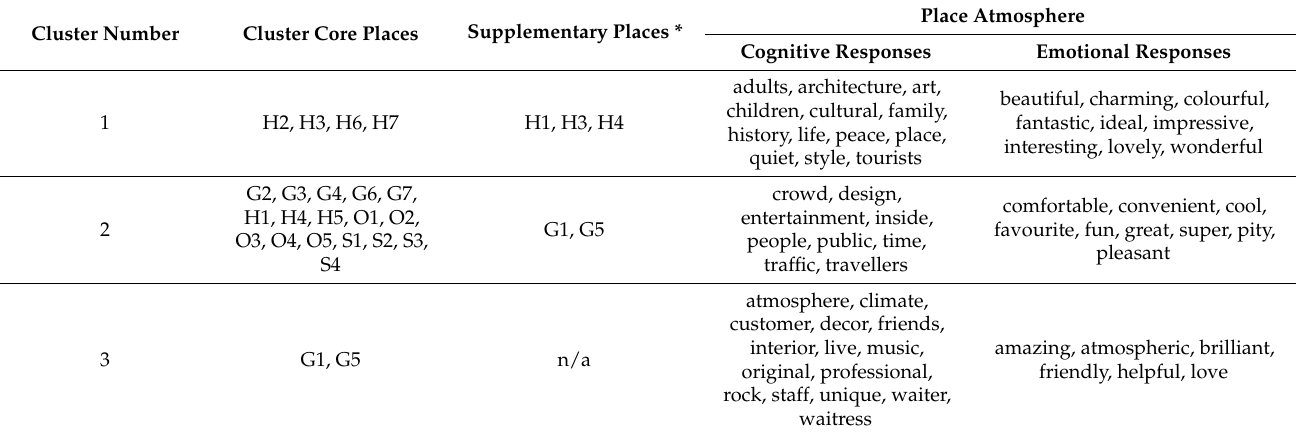
Table 7. Results of hierarchical clustering with regard to core and supplementary cluster places and place atmosphere dimension terms most related to the